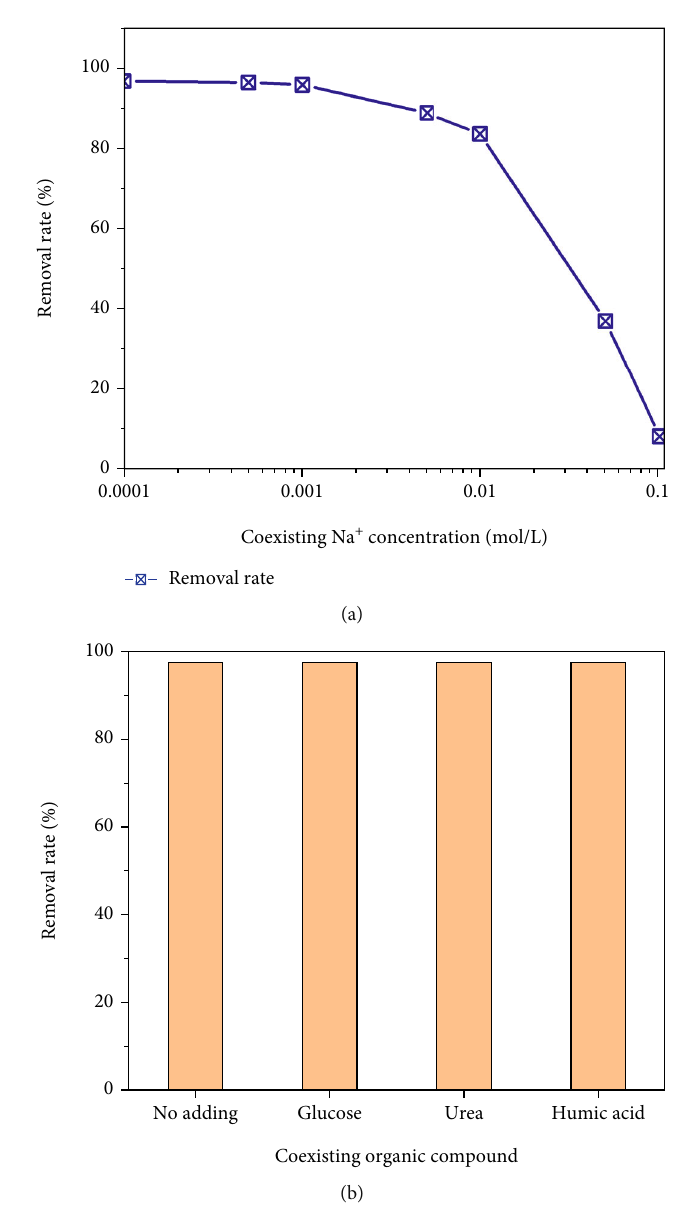
Figure 6: E ff ects of coexisting (a) Na + concentration and (b) organic compounds on MB removal